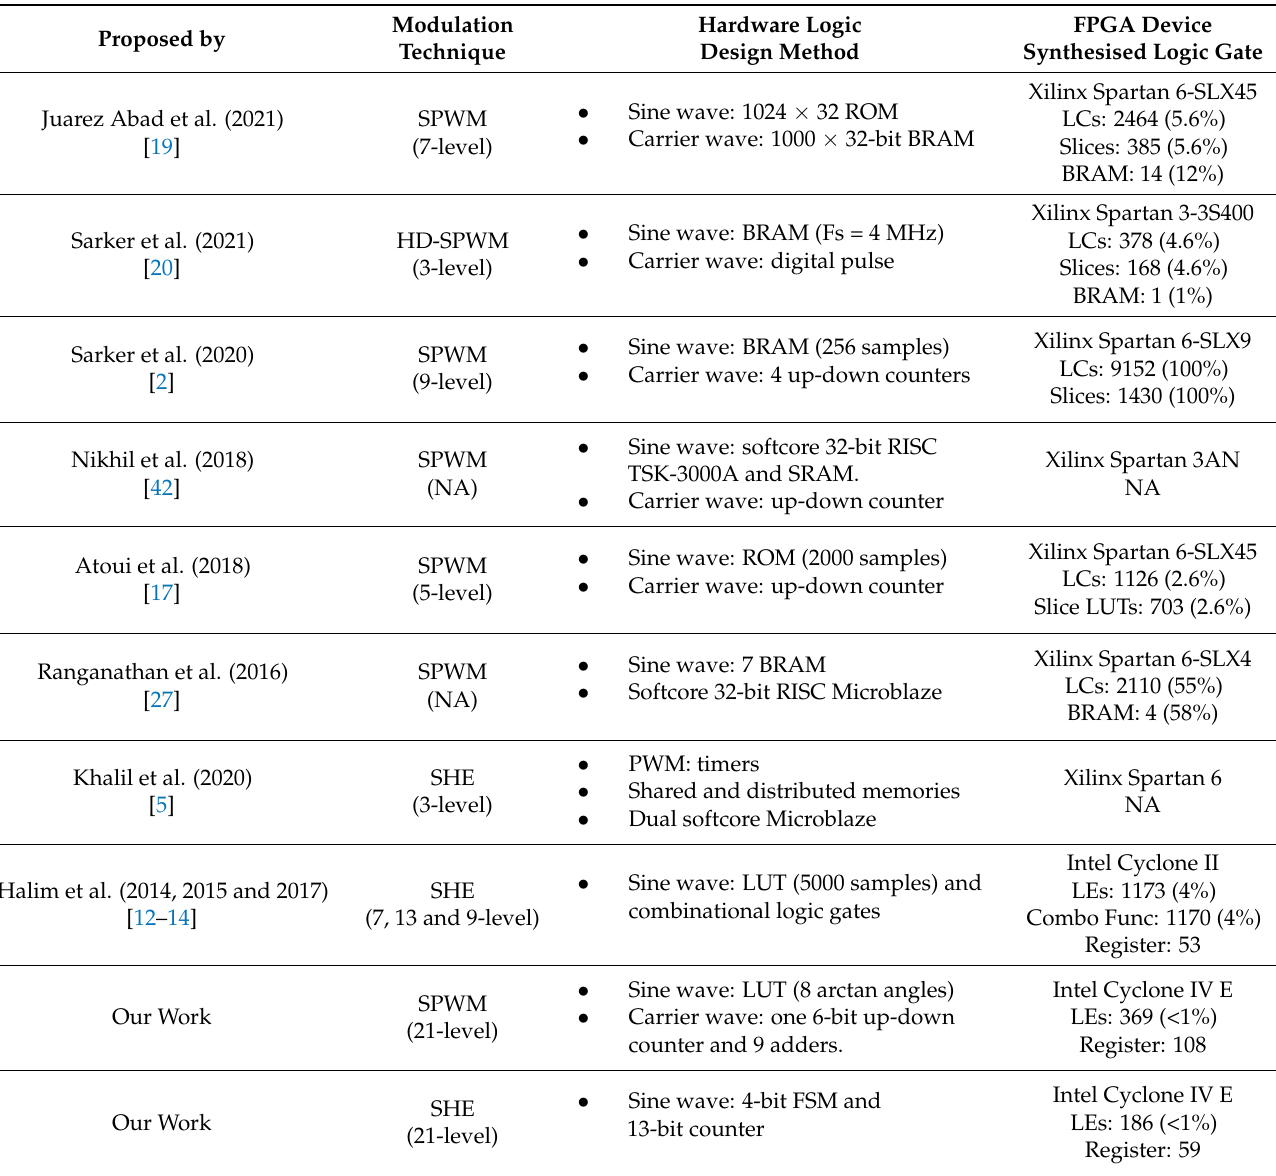
Table 9. Comparison of design architectures of digital switching controllers for SHE and SPWM modulation